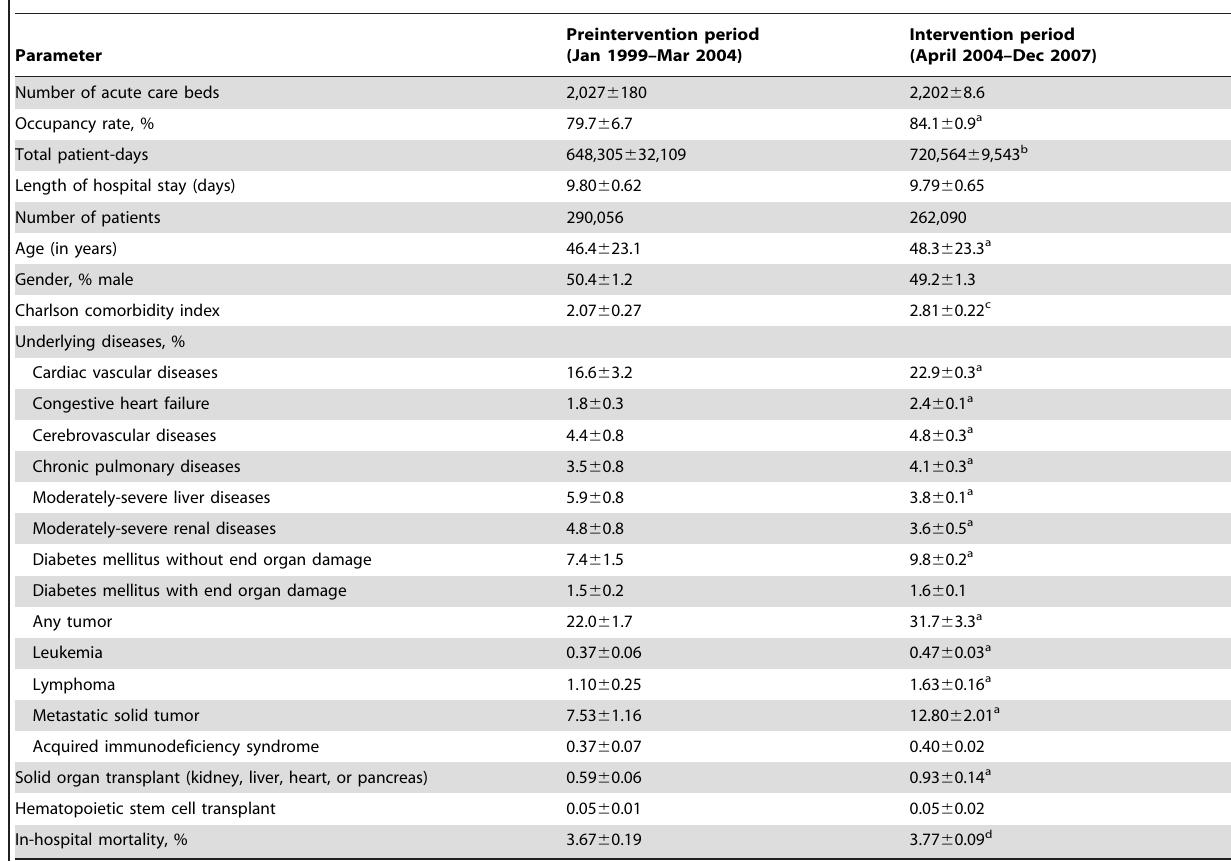
Table 1. Characteristics of the Patient